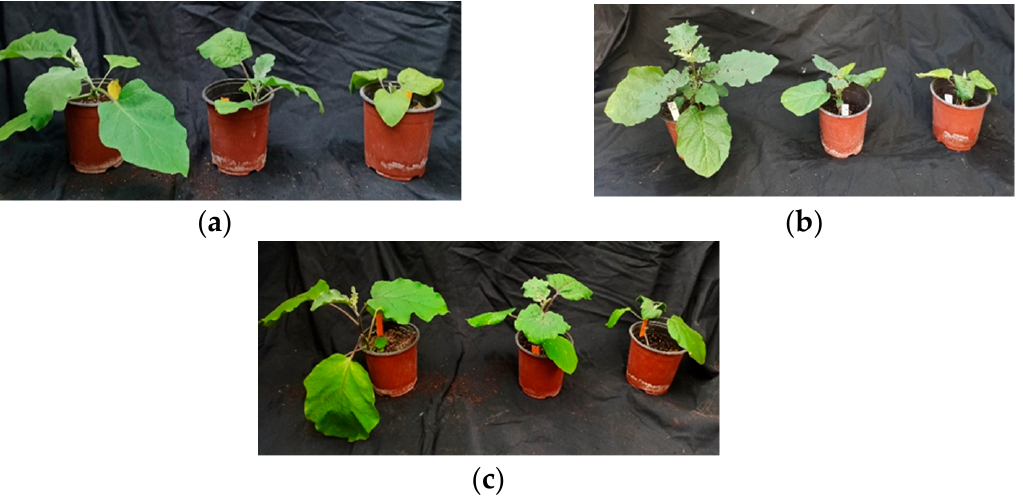
Figure 1. Solanum melongena ( a ), hybrid ( b ) and Solanum insanum ( c ) plants at the end of the four-week growth period, in the control, and the 200 mM NaCl and 400 mM NaCl salt treatments (from left to right).